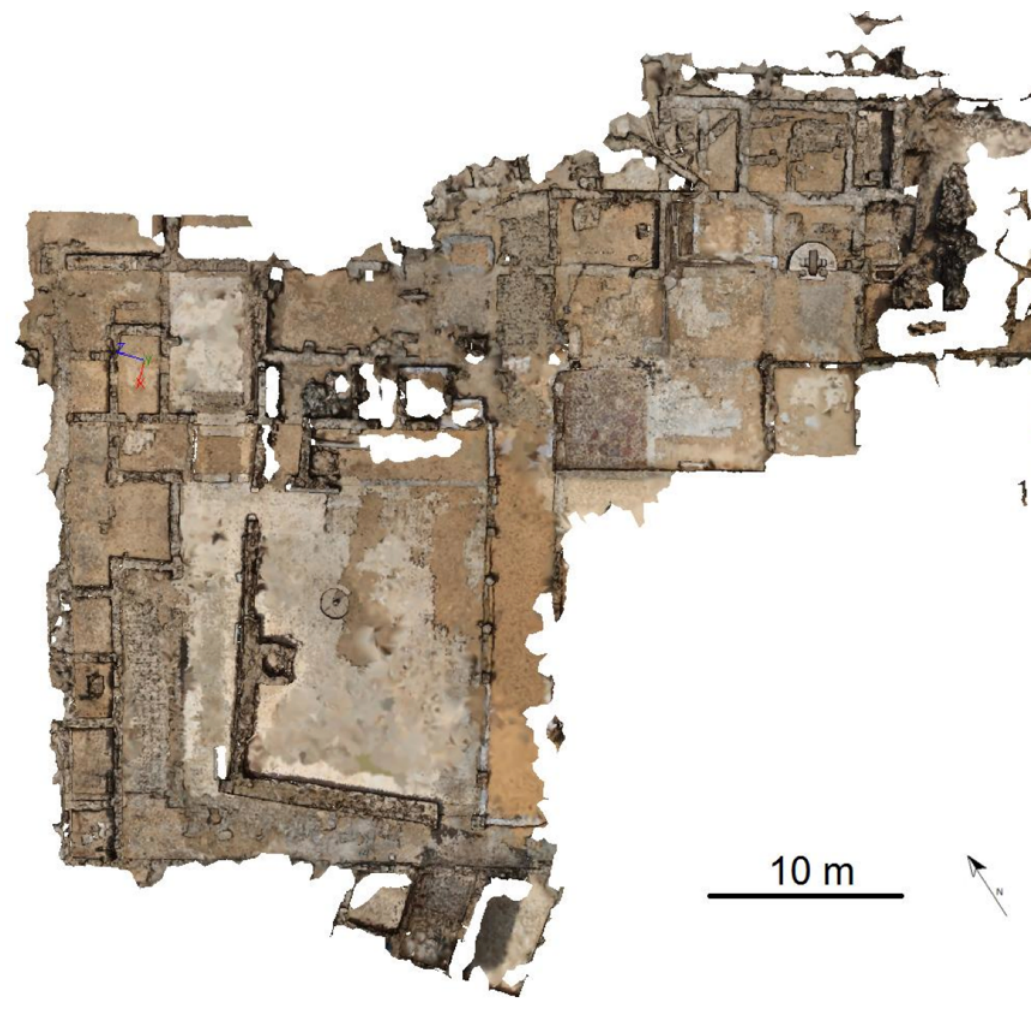
Figure 7: textured mesh of sector 2, top